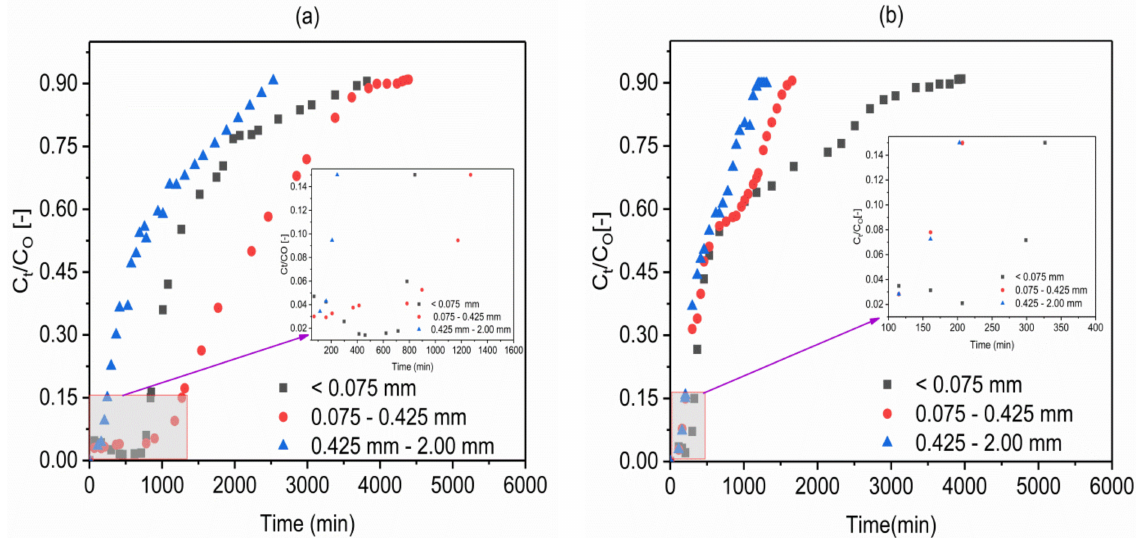
Figure 5. Effect of particle sizes on the breakthrough behavior of fluoride in ( a ) VPum and ( b ) VSco at (pH 2.00; influent fluoride concentration 10 mg/L (C O : 10 mg/L); flow rate 1.25 mL/min (Q O : 1.25 mL/min; bed depth 10 cm). Table 2. Fixed-bed column parameters obtained for fluoride adsorption onto VPum and VSco.